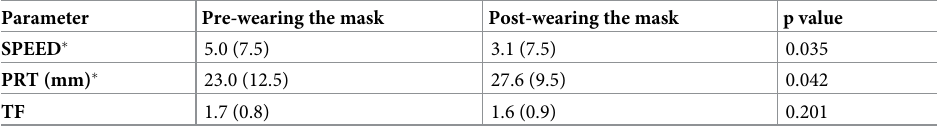
Table 1. The median (IQR) for the SPEED, PRT, and TF scores in subjects with a high BMI (n = 25). Parameter